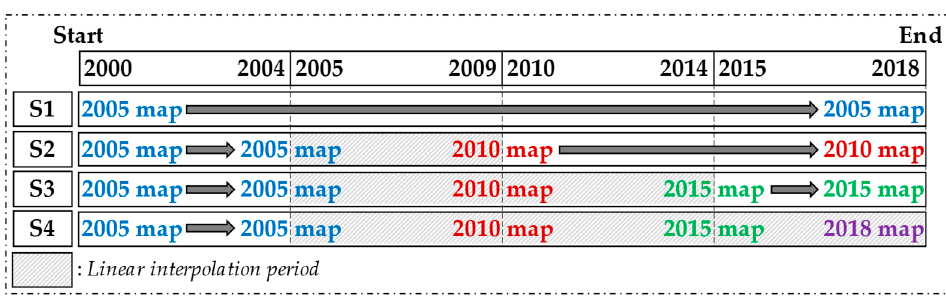
Figure 3. Land-use map input conditions in simulation scenarios 1–4. S1 represents the static input condition, and S2, S3, and S4 represent the three updated input conditions.